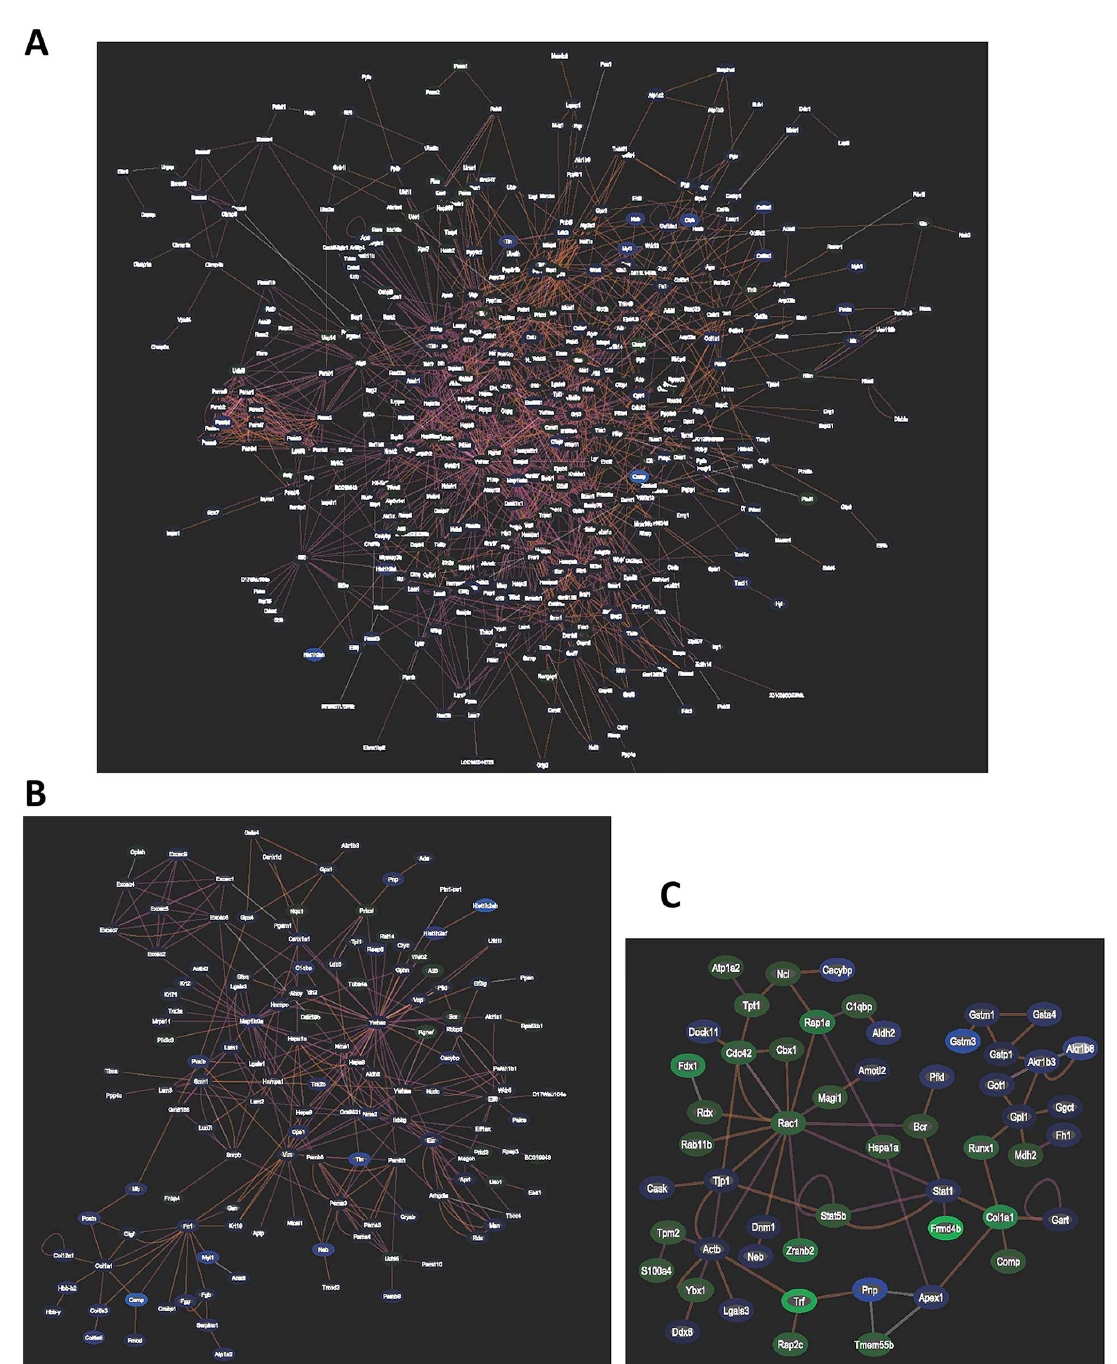
Fig 3. Network analysis of differentially expressedproteins with 1.5-fold changes. (A) The network of differentially expressed proteins from the cells irradiatedby 0.2 Gy of carbon-ion radiation with an LET of 12.6 keV/ μ m. (B) The network of differentially expressed proteins from the cells irradiated by 2 Gy of carbon-ion radiation with an LET of 12.6 keV/ μ m. (C) The network of differentially expressed proteins from the cells irradiated by 2 Gy of carbon-ion radiationwith an LET of 31.5 keV/ μ